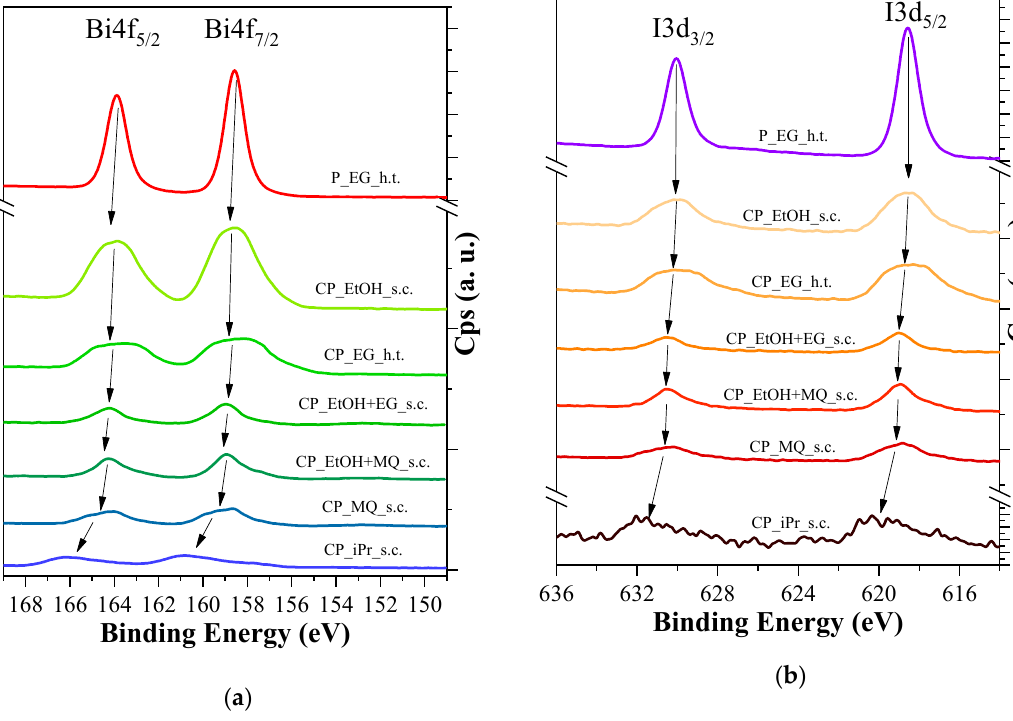
Figure 8. Bi4f spectra (a) and the I3d (b) XPS spectra of the immobilized BiOI layer. The shift of the peak position due to the different solvents and the solvent mixtures indicated the change of the surface chemical environment.